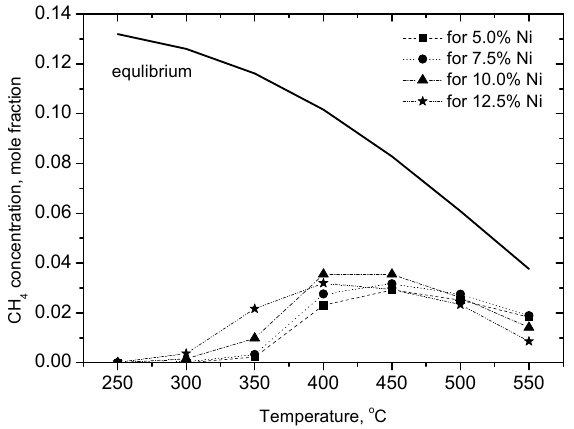
Figure 10. Methane concentration as a function of temperature at the reactor outlet over catalysts with different nickel loading.